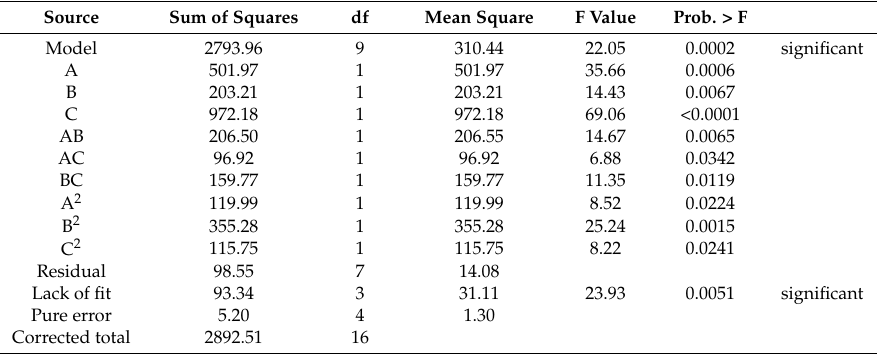
Table 7. Analysis of the variance (ANOVA) of the quadratic model.